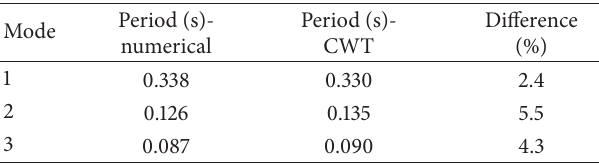
Table 3: Comparison of the periods extracted from CWT method and modal